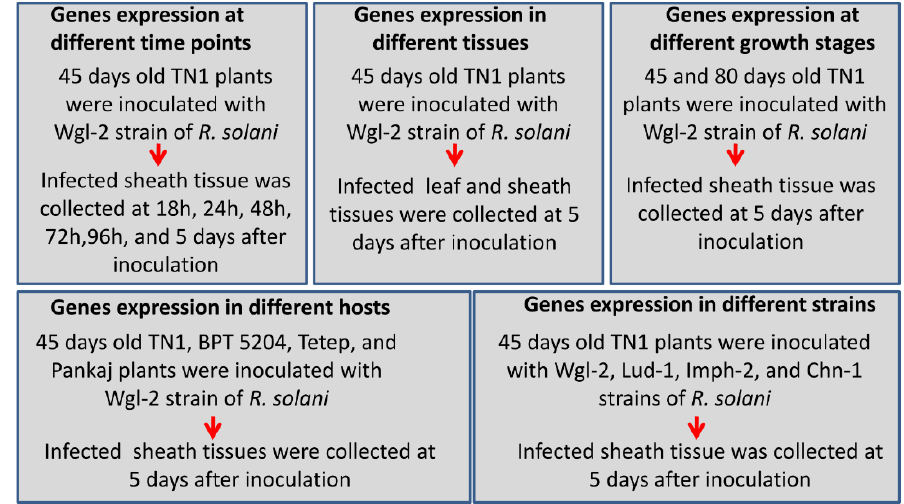
Figure 1. Details of sample preparation for the qRT-PCR experiments. The samples were prepared to evaluate the fungal genes expression at different time points of infection and in different tissues, growth stages, and genotypes of rice. Gene expression was also analyzed in different strains of R. solani .